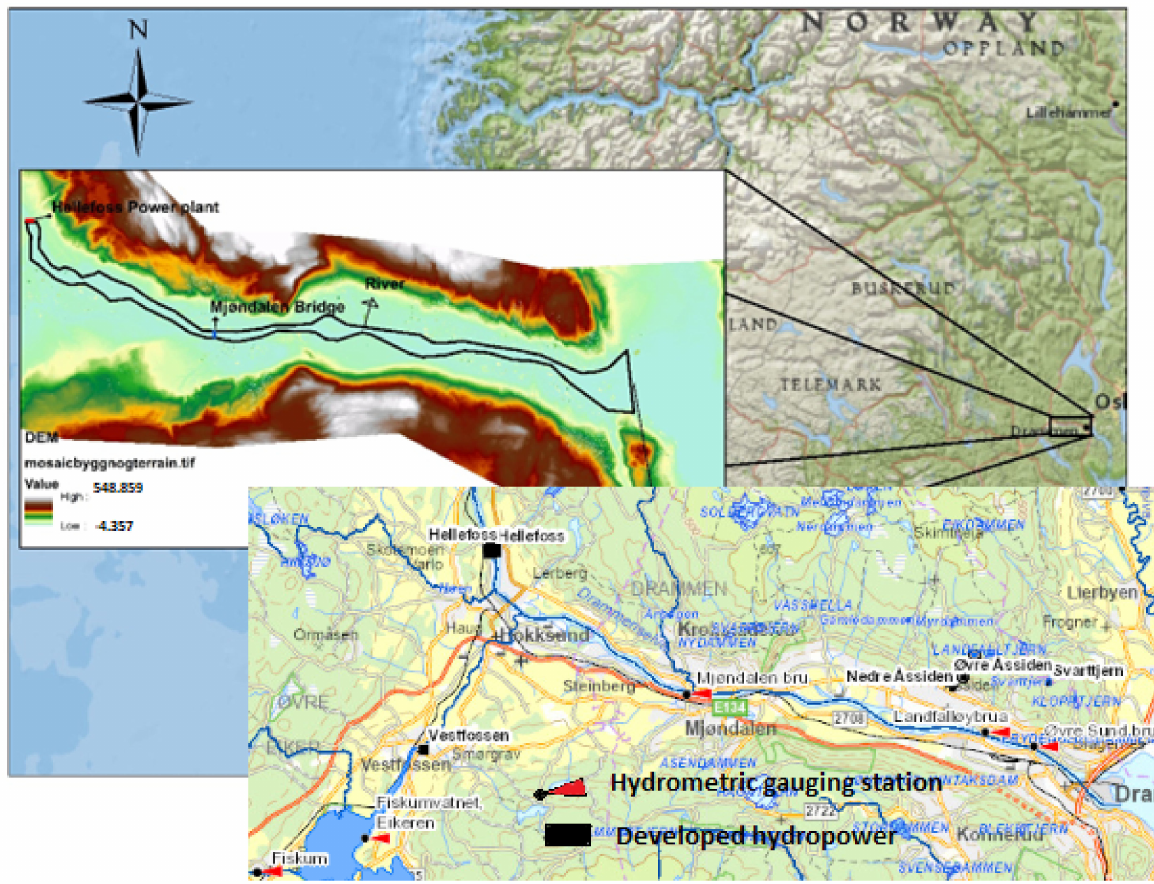
Figure 1. Location of the study area